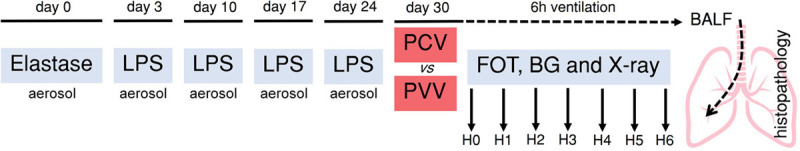
Schematic representation of the experimental protocol. LPS, lipopolysaccharide; PCV, pressure-controlled ventilation; PVV, physiologically variable ventilation; FOT, forced oscillation technique; BG, blood gas; BALF, bronchoalveolar lavage fluid; H0 to H6, measurement time points at hour 0 to hour 6.